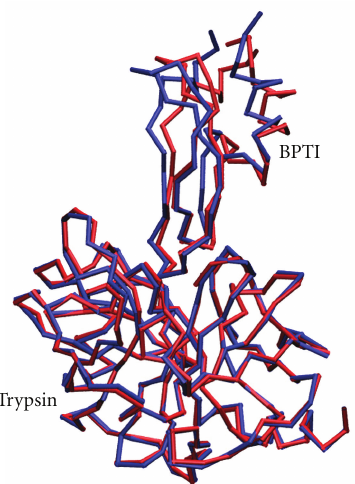
Figure 6: The superposition of the predicted Trypsin/BPTI com- plex (blue) with the crystal complex (red) structures. The RMSD between the predicted and crystal BPTI structures is 3.2